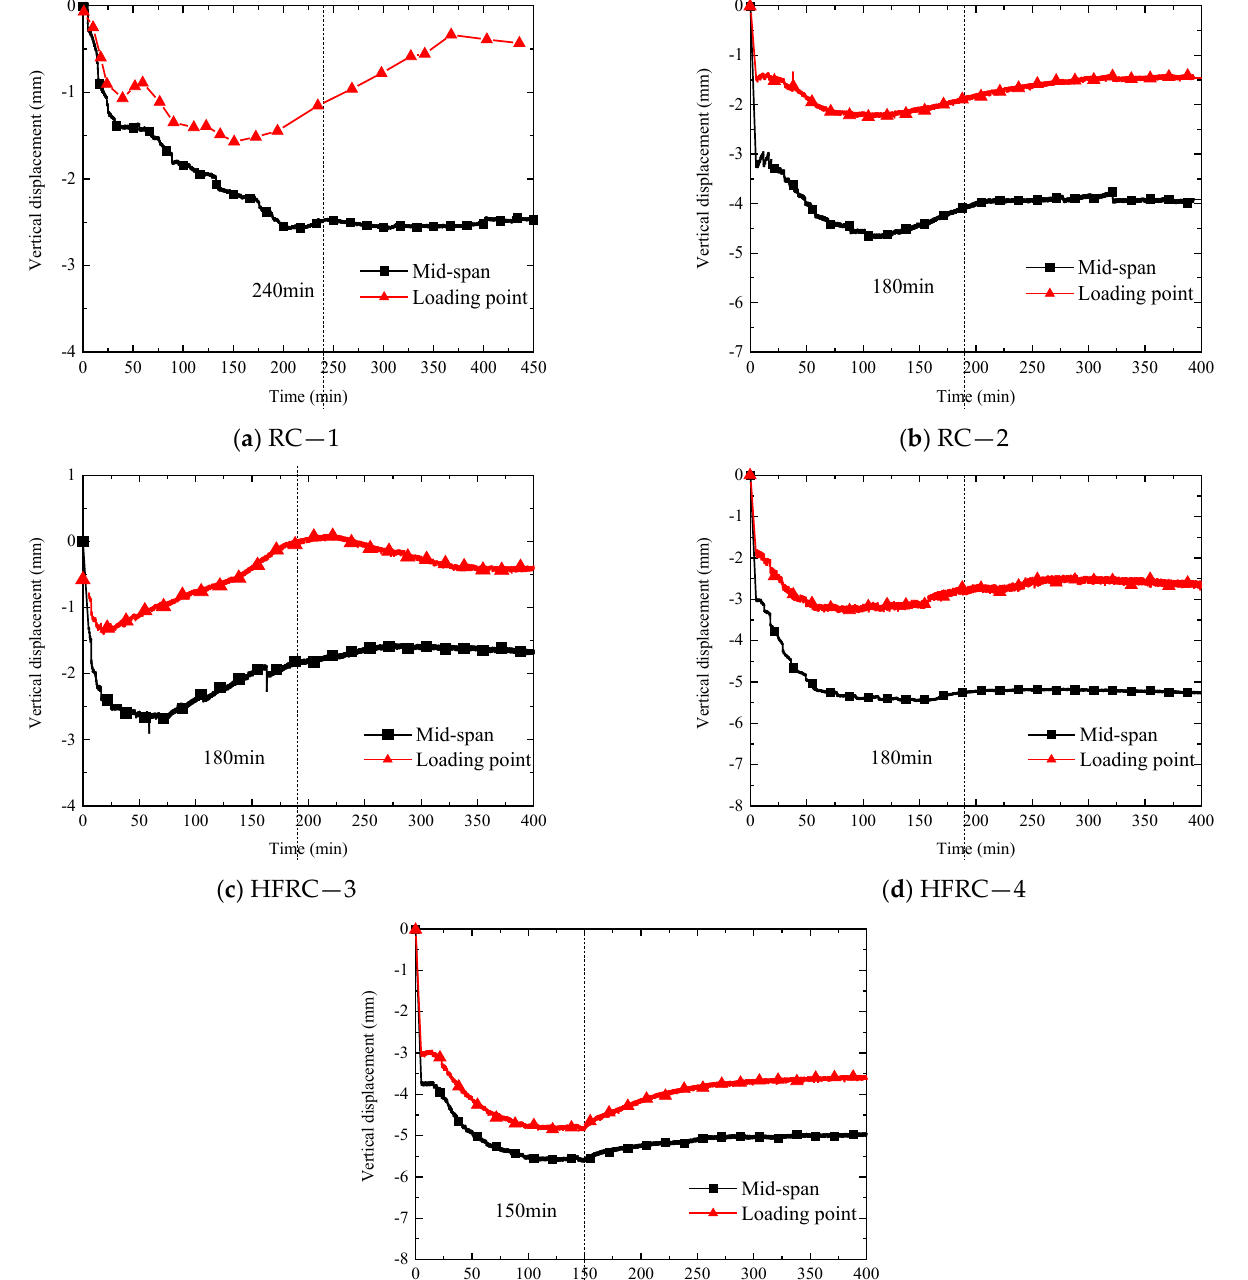
Figure 14. Vertical displacement–time curves: ( a ) RC—1; ( b ) RC—2; ( c ) HFRC—3; ( d ) HFRC—4; and ( e ) HFRC—5.